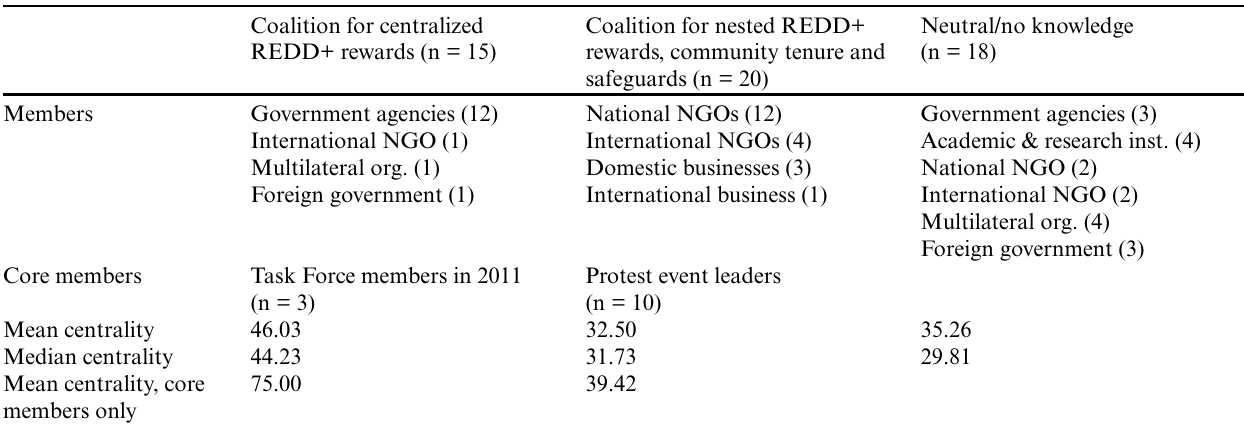
Table 2 . Centrality of REDD+ discourse coalitions and their core organizational members, measured as the normalized indegree of perceived